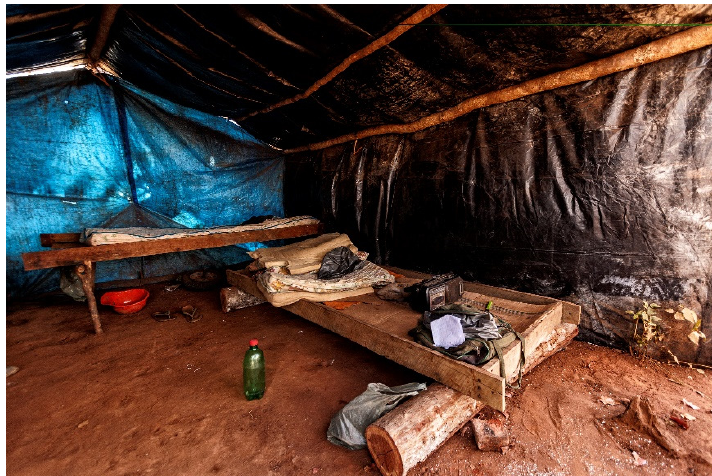
Figure 3. Common structure in neoslavery accommodation (Sérgio Carvalho).